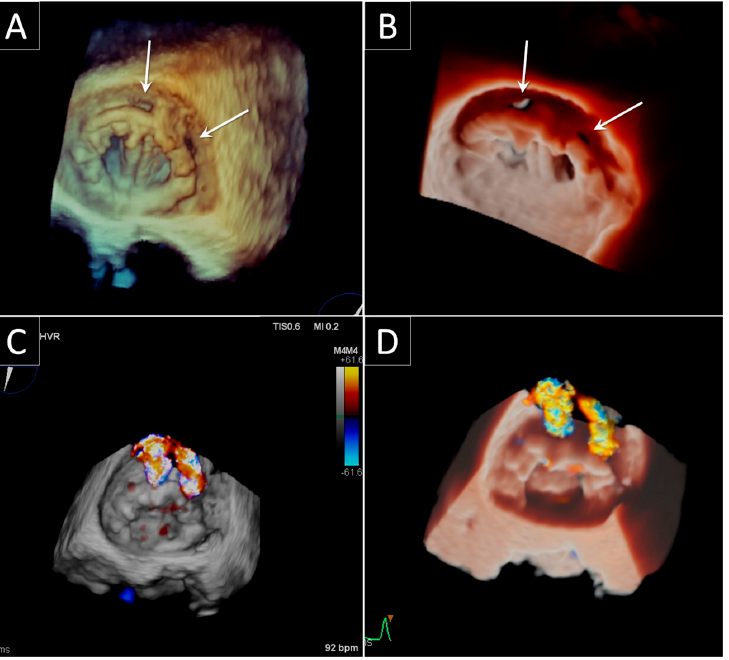
Figure 4. Bileaflet mechanical mitral paravalvular leak. ( A ) Standard 3D TEE rendering and ( B ) tran- sillumination technique of the bioprosthetic mitral valve from atrial perspective showing two par- avalvular leaks (arrows) at the prosthetic anterior hinge point and at 2 o’clock. ( C ) Standard 3D TEE rendering and ( D ) transillumination merged with 3D color demonstrating the two jets of regurgitation throughout the paravalvular